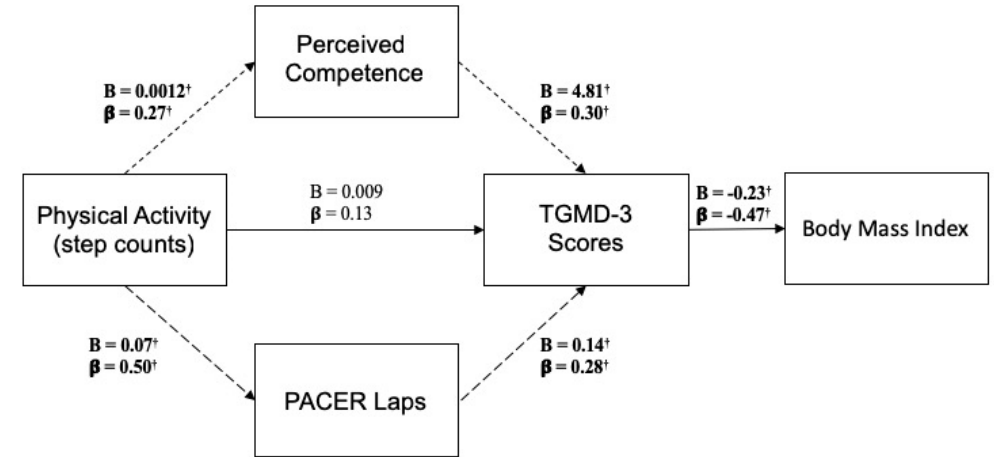
BMI stands for Body Mass Index; PACER stands for the Progressive Aerobic Cardiovascular Endurance Run; TGMD-3 stands for the Test of Gross Motor Development-3rd Edition; bold and † denotes statistical differences between sexes, p < 0.05.